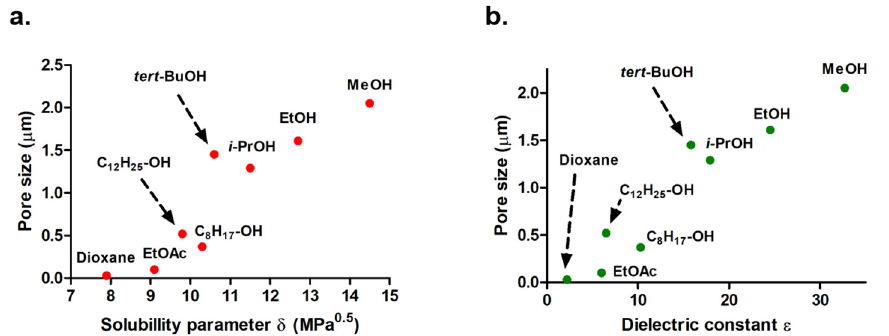
Figure 2. Evolution of pore size in the prepared monoporous materials as a function of ( a ) solubility parameter δ or ( b ) dielectric constant of the porogenic solvent used. Table 1. Porous features of monoporous VMA-based networks synthesized using various solvents as porogenic agents. The VMA/EGDMA molar ratio was fixed at 70/30 mol.% and the volume ratio of co-monomers/solvent was equal to 20/80 vol.%.